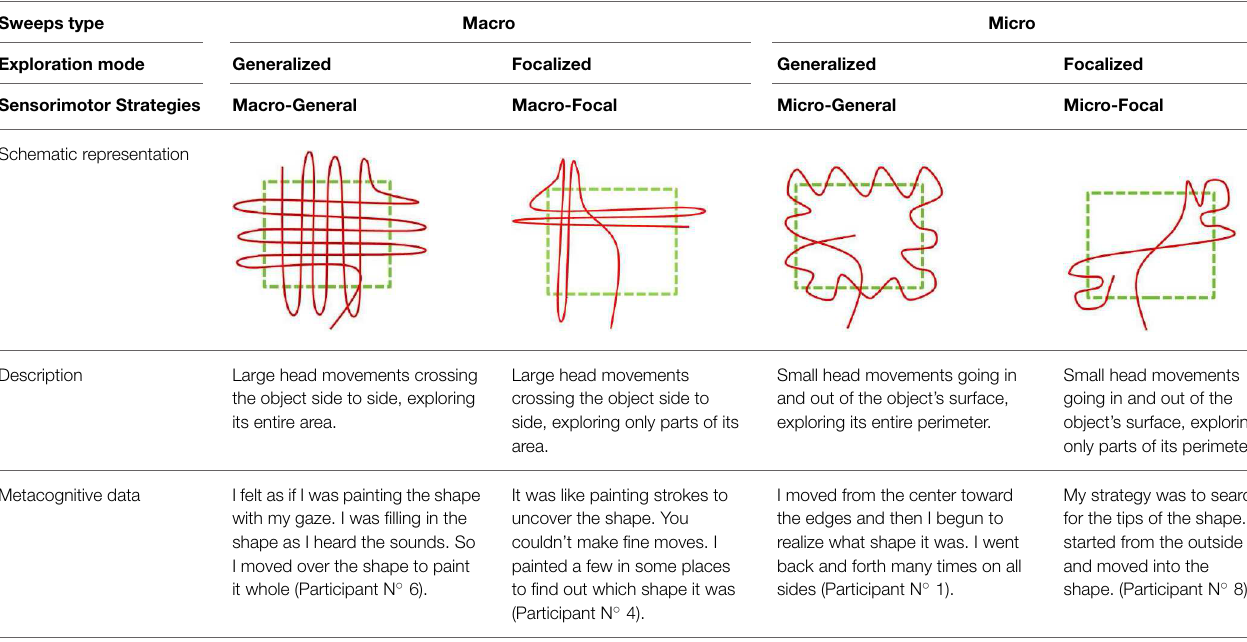
TABLE 2 | Components of sensorimotor strategies in Experiment